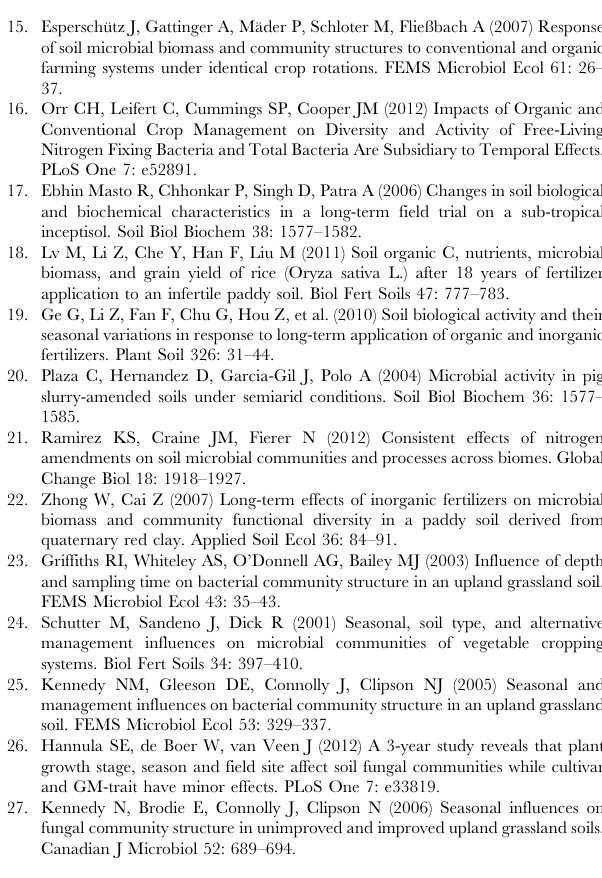
Figure S1 Rarefaction curves of bacterial communities for June (A) and October (B) based on the number of observed OTUs at 3% distance calculated from the randomly selected 10,000 pooled sequences of each treatment. Error bars indicate 95% confidence intervals. Table S1 Soil available K of all samples from different fertilizer regimes both in June and October. Table S2 Soil microbial biomass C (MBC) and micro- bial biomass N (MBN) of all samples from different fertilizer regimes both in June and October.